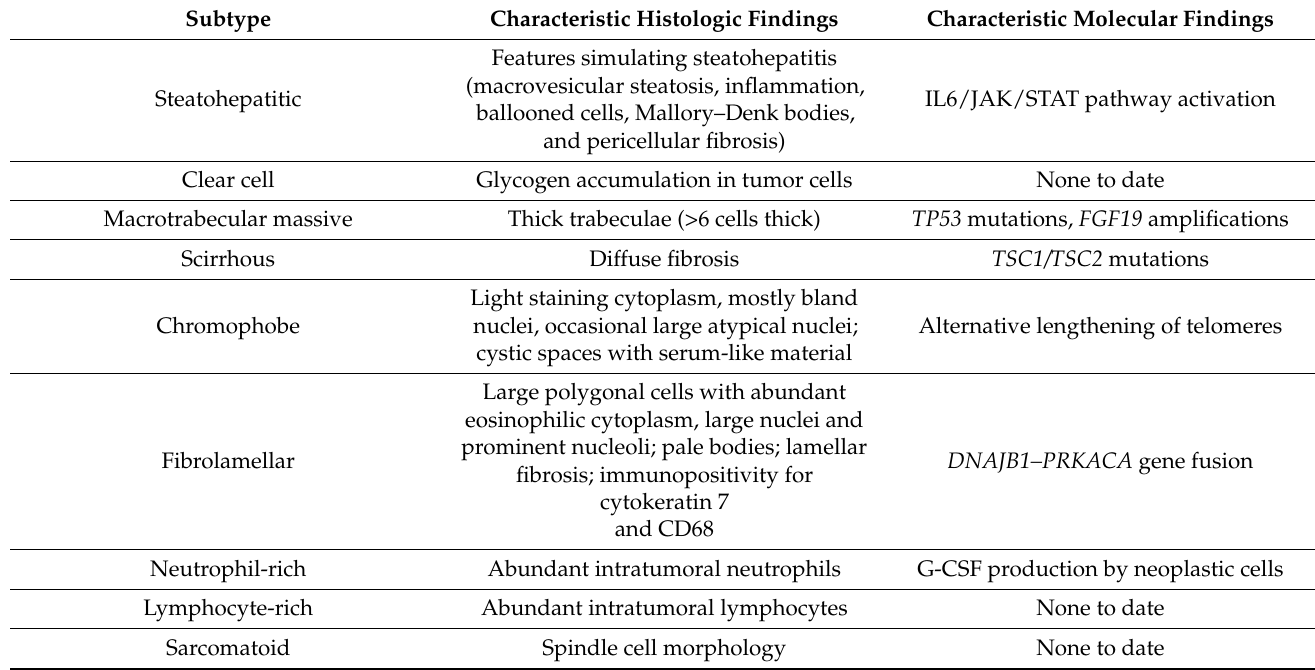
Table 2. Characteristic histologic and molecular findings of hepatocellular carcinoma